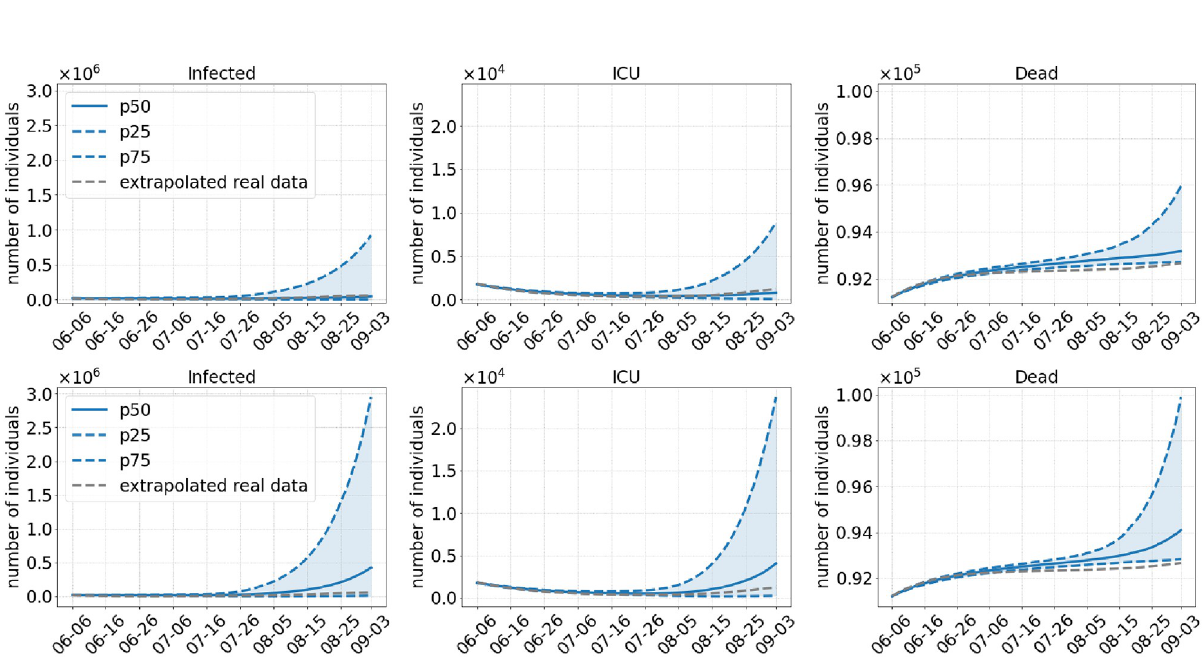
Fig 6. Results of Scenario 2 with identical time span for carrier and infected individuals either unvaccinated or partially or fully vaccinated; κ = 1; cf. Fig 1: Commuter testing once a week, local NPIs decreed until July 01, 2021, keeping masks and distancing after opening. The median of 500 runs is shown in solid blue; the blue dotted lines are the 25% and 75% percentiles. The top row shows results with an assumed 40% more transmissible Delta variant compared to 60% in the bottom